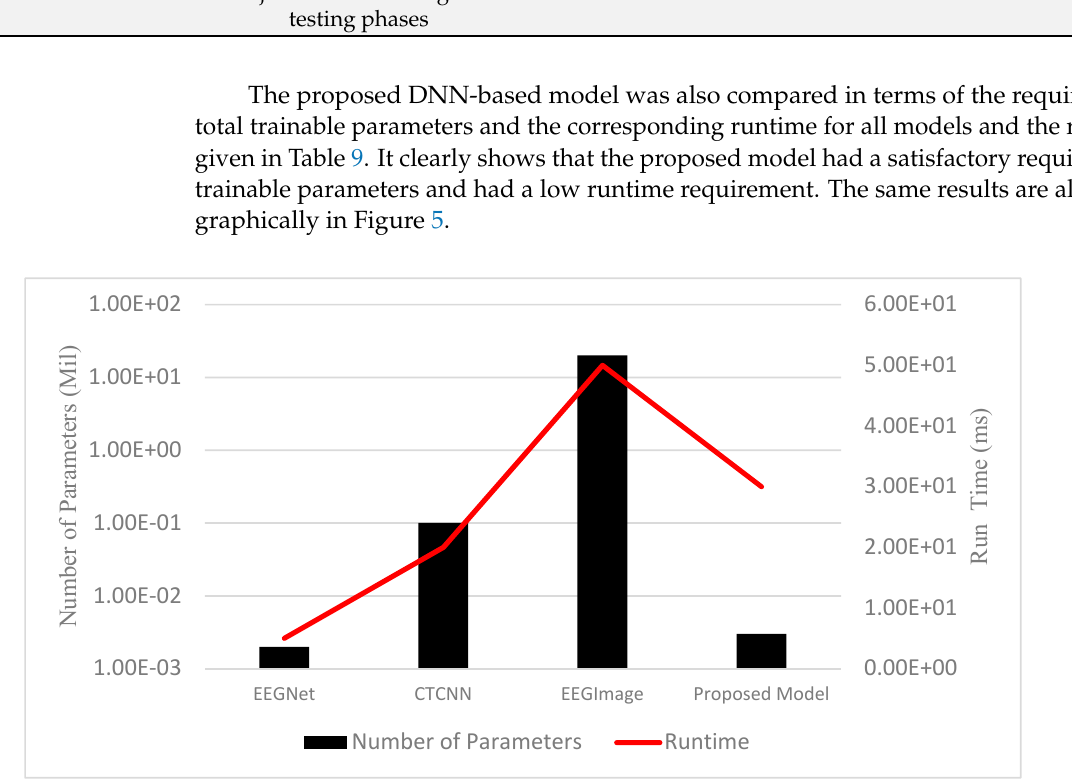
Table 8. Comparison of proposed model with recent models.